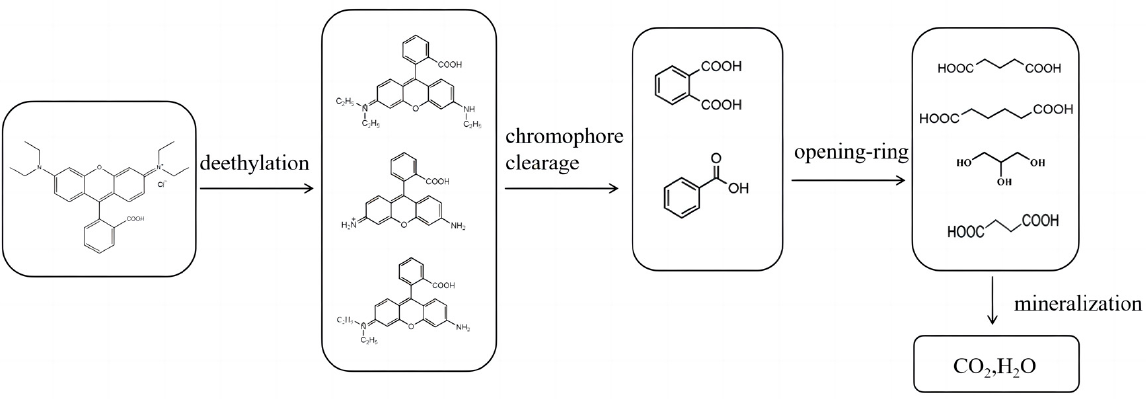
Figure 9. The degradation pathway of RhB